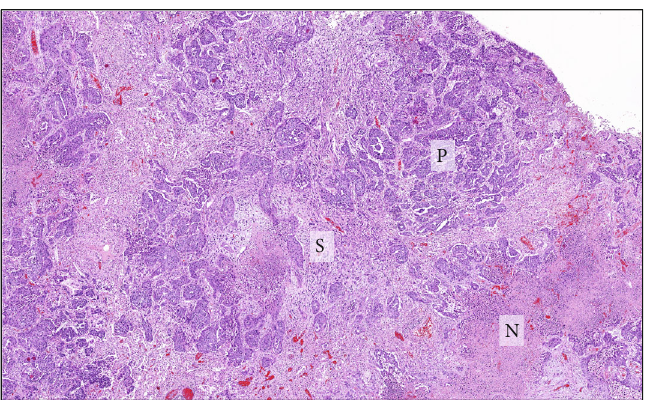
Figure 3: Subgross image. Hematoxylin and eosin staining showing trabeculae and nests of polygonal cells (P), streams and bundles of spindle cells (S), and areas of necrosis